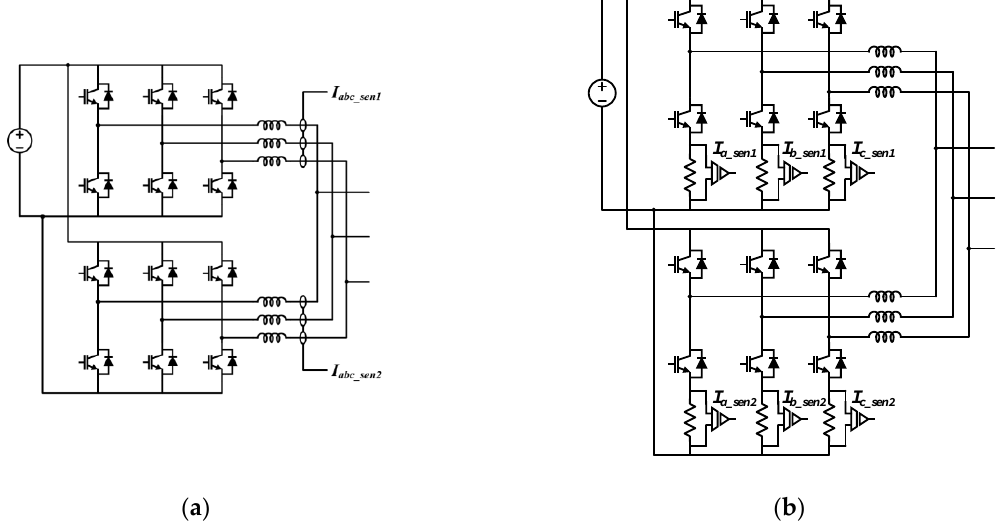
Figure 1. Phase current measurement methods using multiple sensors or shunt resistors in 3 phase parallel inverter. ( a ) Current measurement with six current sensors ( b ) Current measurement with six shunt resistors.